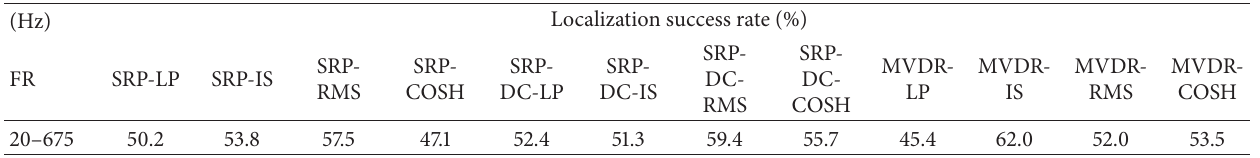
Table 4: Results of Test 2 using two car